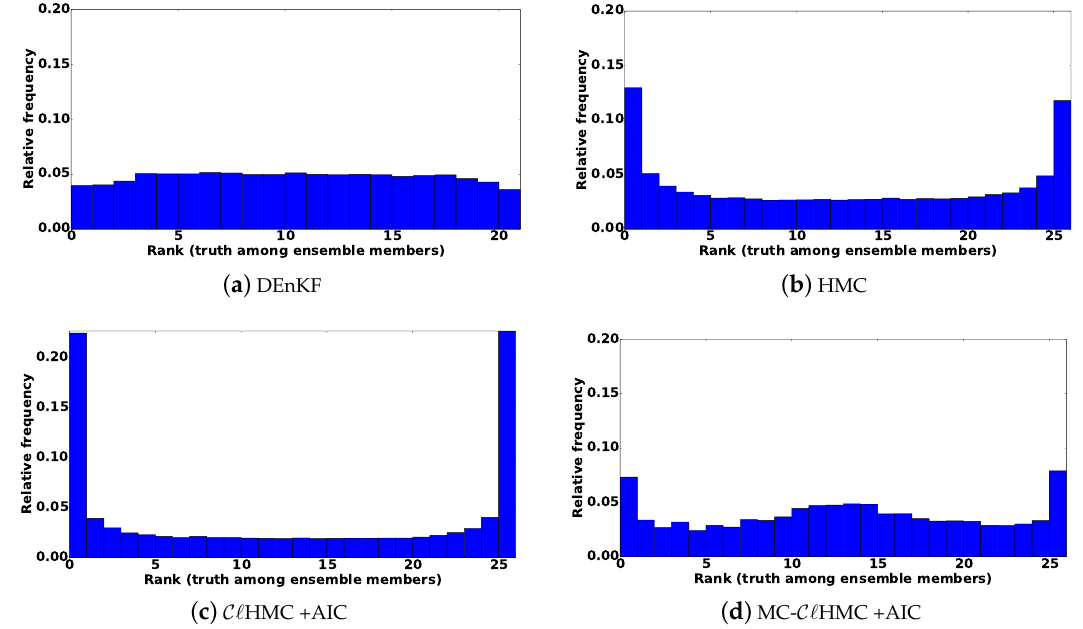
Figure 5. Data assimilation results with the linear observation operator. The rank histograms of where the truth ranks among posterior ensemble members. The ranks are evaluated for every 16th variable in the state vector (past the correlation bound) at 100 assimilation